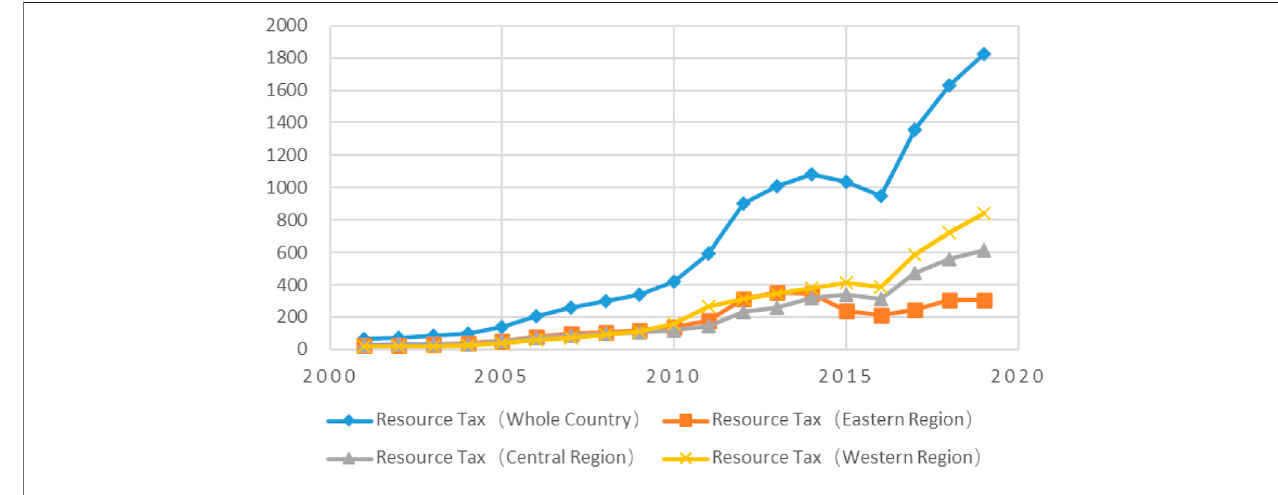
FIGURE 1 | China ’ s resource tax revenues and regional differences.